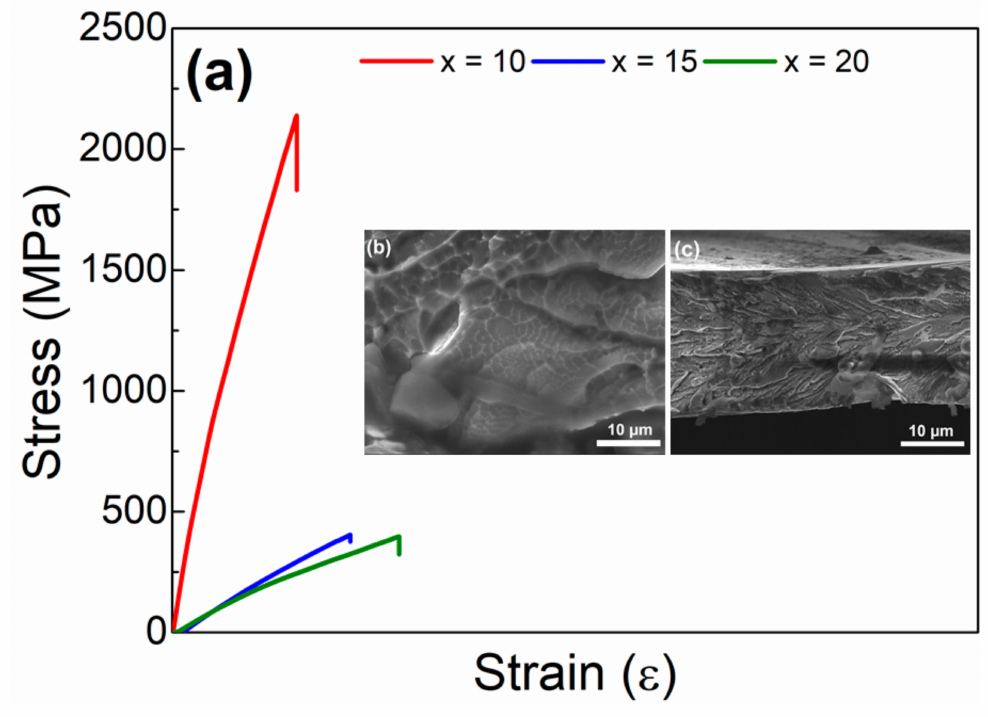
Figure 3. ( a ) Tensile stress–strain curve for Fe 91 − x Zr 5 Nb 4 B x (x = 10, 15, 20 at%) melt-spun ribbons. Inset: SEM micrographs of fracture of ribbon tested with 10 at% B where is observed for ( b ) a well- defined vein pattern and ( c ) the magnifying micrograph from the previous image with river-like morphology